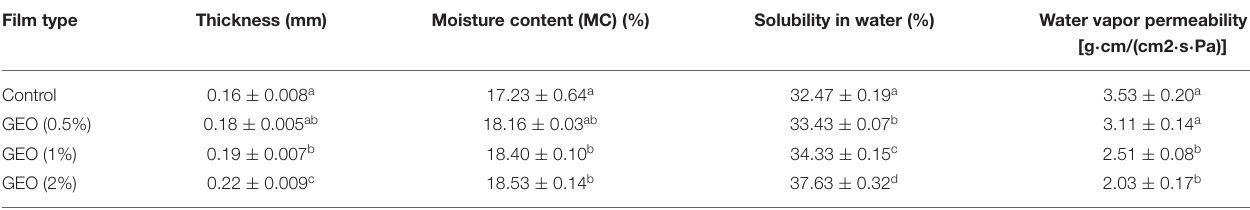
TABLE 1 | Functional properties of the cassava starch-based films supplemented with GEO. Film type